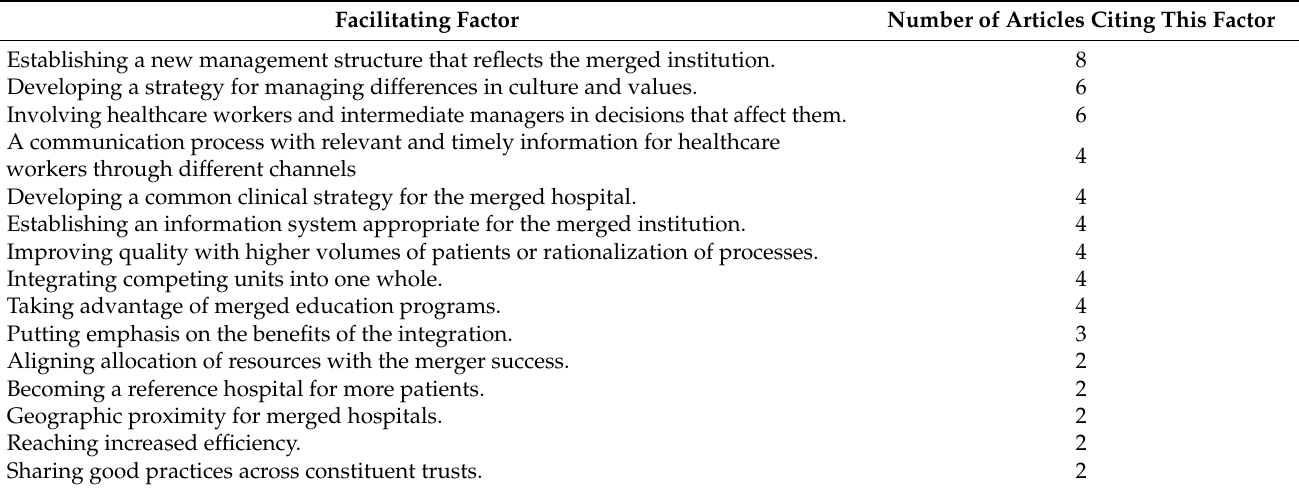
Table 3. Number of articles citing facilitating